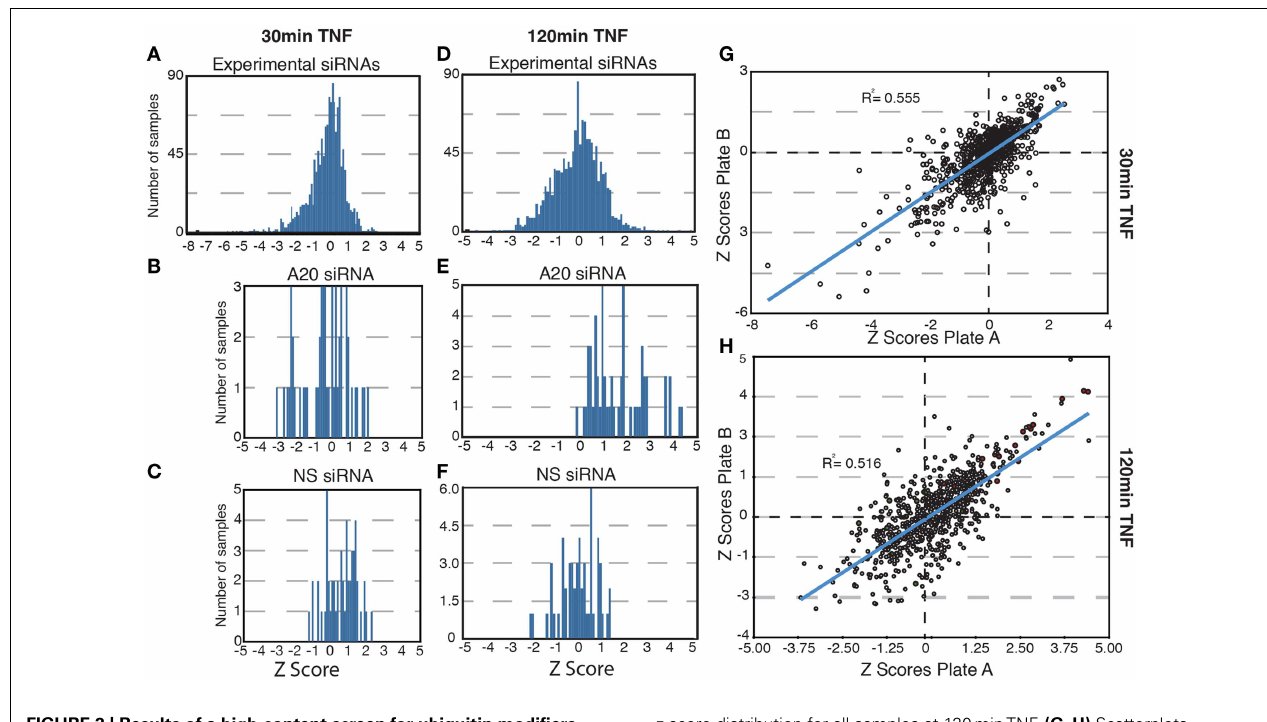
FIGURE 2 | Results of a high-content screen for ubiquitin modifiers of NF- κ B . (A–E) The distribution of z -scores are shown for all samples (A,D) ; samples treated with control, non-silencing siRNAs (NS, C, and F); or samples treated with controls A20 siRNA (B,E) . (A–C) Show the z -score distributions for all samples at 30minTNF and (D–F) show the